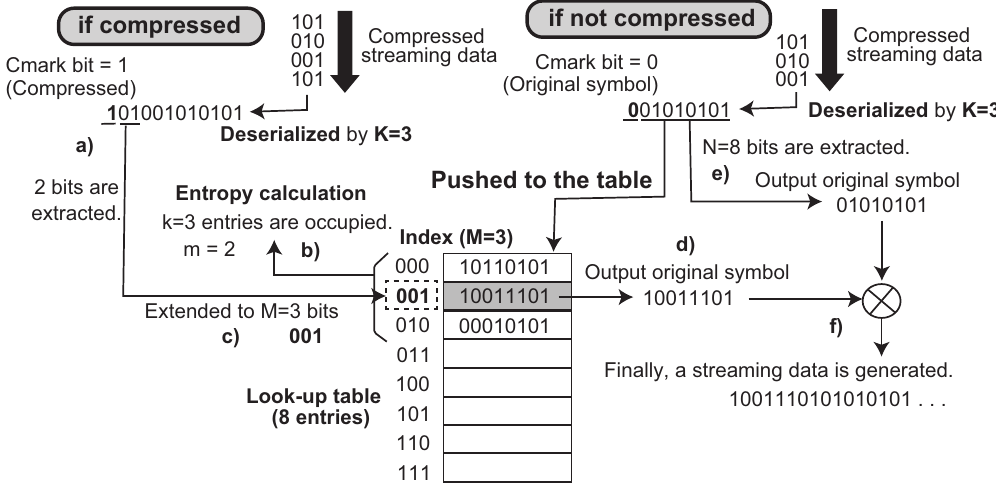
Figure 3. Decompression mechanism in ASE coding. The decompressor checks the first bit of the compressed data stream. As shown in the left side, ( a ) when the Cmark is set, ( b ) the entropy calculation generates two due to the occupation of the look-up table. From the data stream, two bits are picked up as a compressed data. Subsequently, ( c ) the data are extended to three bits. ( d ) It is used as an index of the look-up table and outputs the data in the associated table entry as the original symbol. Besides, ( e ) when the Cmark is reset, the original symbol is received. Eight bits are picked up from the stream and it is generated as the original symbol. Concurrently, the symbol is registered to the